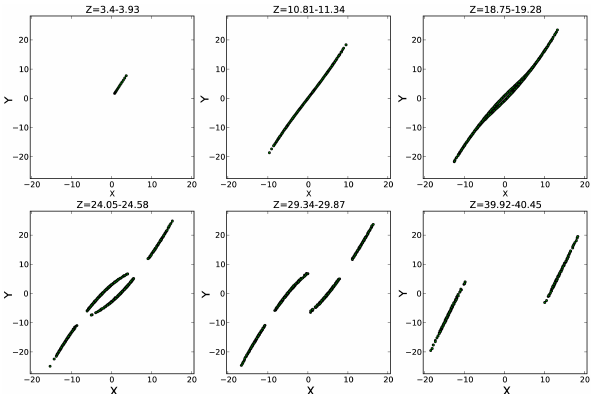
Figure 10. Horizontal slices (in X – Y planes, Z intervals indicated on tops) through L63 attractor. In the two bottom left graphs, the two modes in the center are parts of the descending branches of the lobes ( Z decreases with time), while the modes in the corners are the ascending branches.